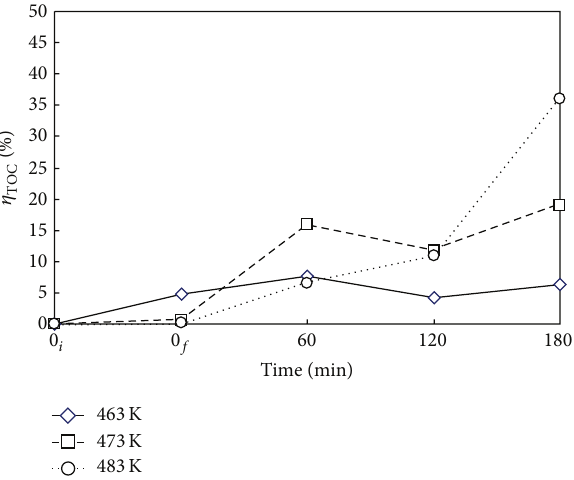
Figure5:TimevariationofmineralizationefficiencyofDMP (𝜂 TOC ) via WOP at various 𝑇 . ⬦ , ◻ , and I : 𝑇 = 463, 473, and 483 K. 𝐶 0 = 100 mgL −1 , 𝑉 𝐿 =400 mL, 𝑃 𝑇 =2.41 MPa,andNr=500 rpm.Working gas after time = 0 𝑓 is O 2